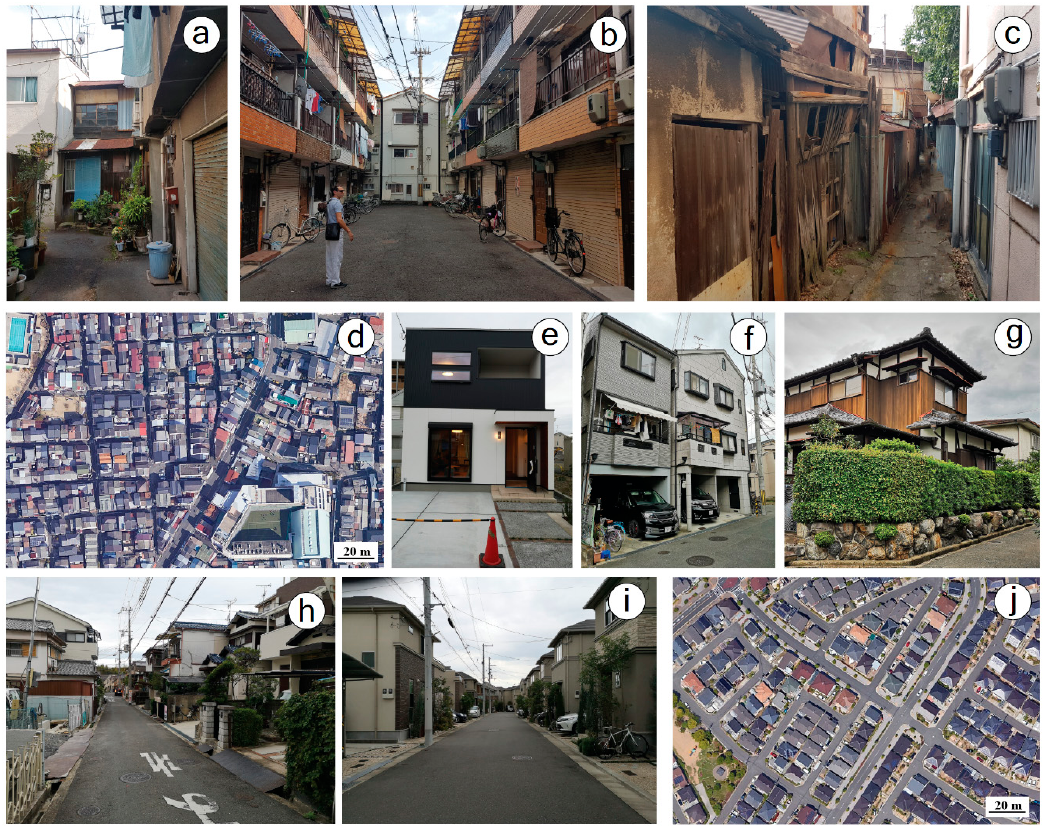
Figure 6. Picture set 2 (Locations: ( a) , ( b) , and ( c) : Nishinari ward, ( d) : Tenn ō ji-ku ward, ( e) , ( f) , ( g) , ( h) , and ( i) : Neyagawa municipality, ( j) : Habikino municipality).